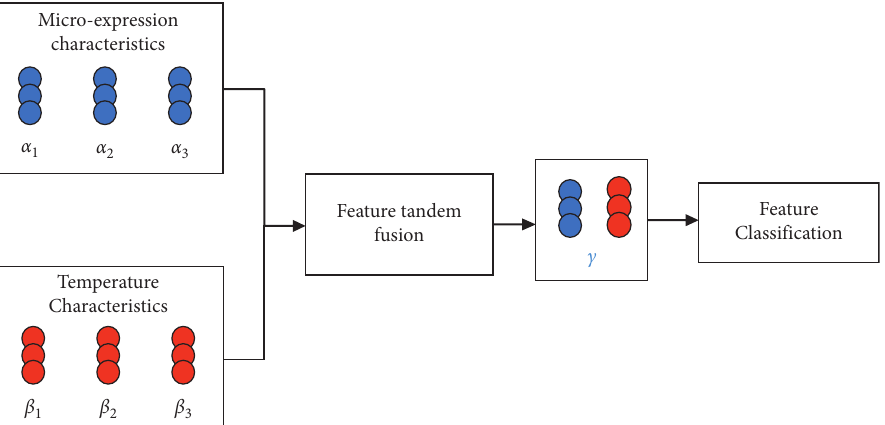
Figure 8: Multimodal feature vector fusion